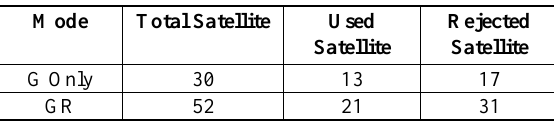
Table 2: Number of Satellites given by magicGNSS software Figure 9 and 10 represent the NEU positioning differences